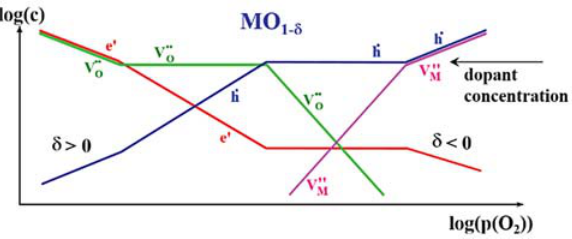
Fig. 3. Sketch of the Brouwer diagram of an acceptor-doped non- indicating the partial pressure depen- stoichiometric oxide MO 1– δ dence of all relevant ionic and electronic defects.